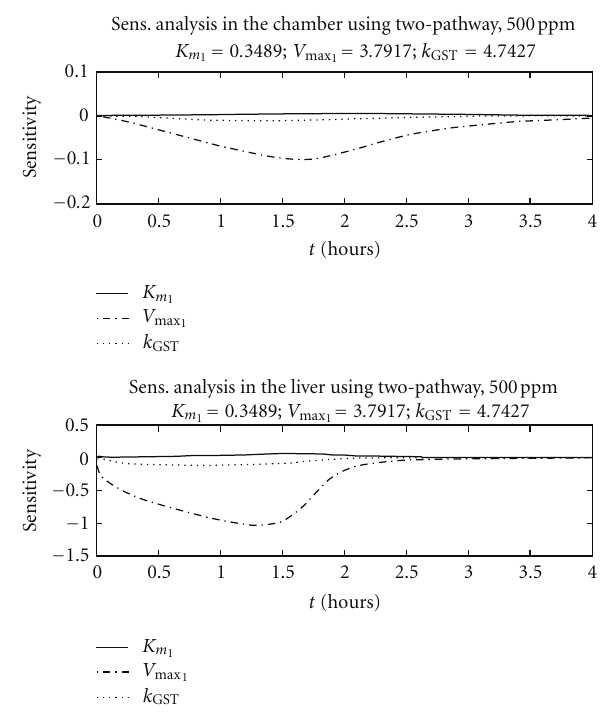
Figure 5: Sensitivity coe ffi cients for the two-pathway model at 500 ppm. Each concentration includes the analysis using air and liver concentrations.